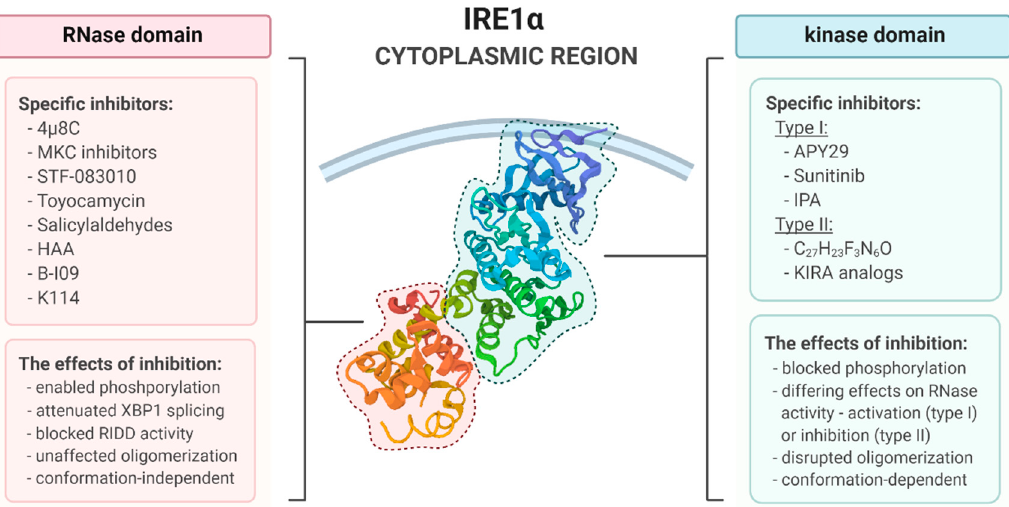
Figure 4. Inhibition of the respective domains within the cytosolic region of inositol-requiring enzyme type 1 α (IRE1 α ) with the specific inhibitors and the major molecular implications associated with their utility.